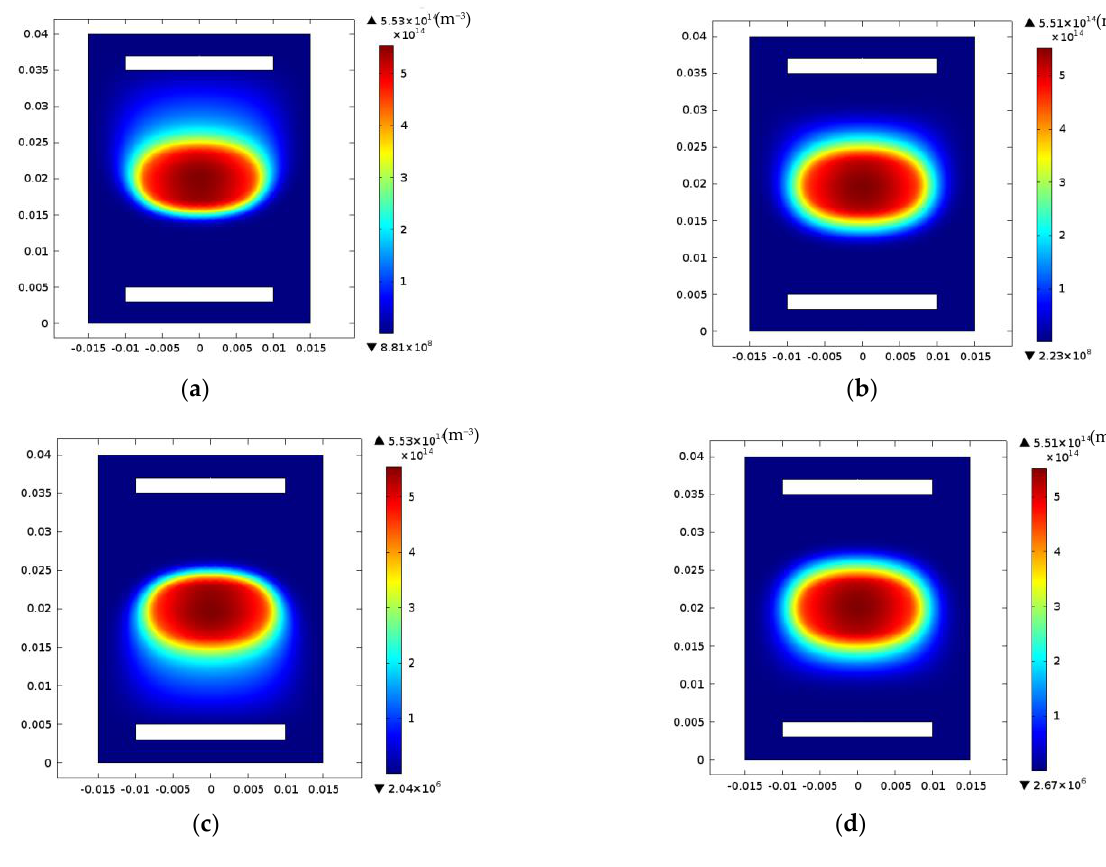
Figure 6. Electron density distribution at different instants of cycle RF (t): (a) t = T /4, (b) t = T /2, (c) t = 3 T /4, and (d) t = T , at 0.3 Torr total gas pressure, RF voltage (150 V, 13.56 MHz), and 20% O 2 .